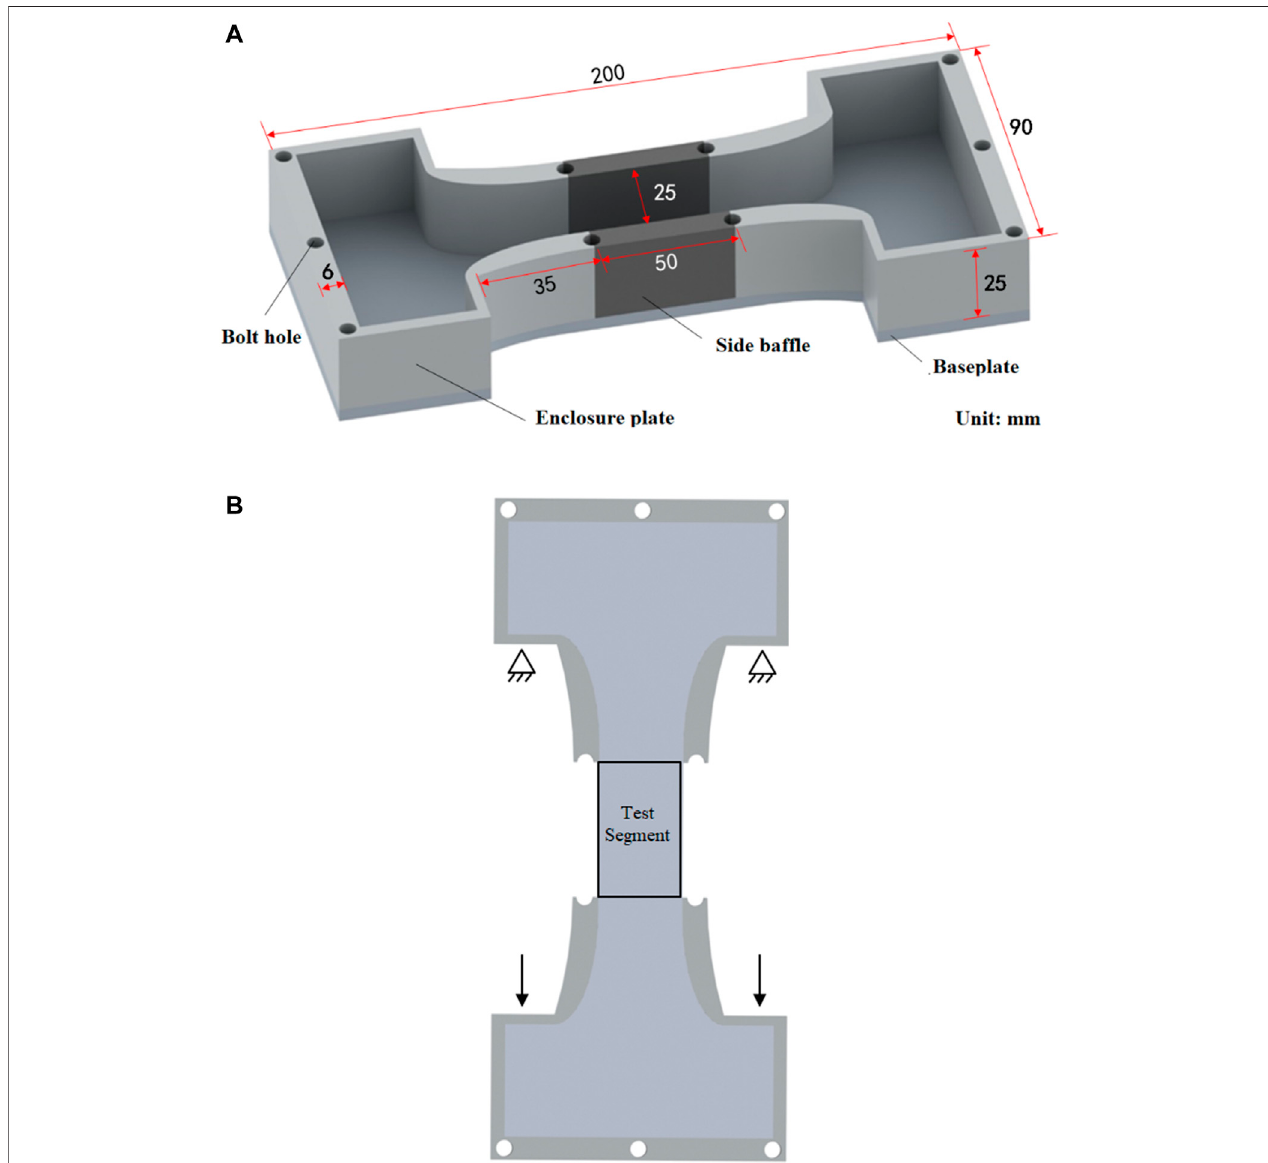
FIGURE 1 | Design and dimensions of the curing mold: (A) dimensions of different parts of the mold and (B) the usage of the mold.